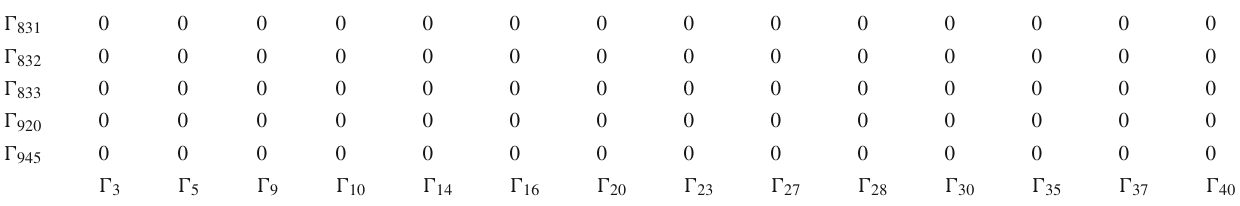
Table 308 Basis quantities correlation coefficients in percent, subtable 4